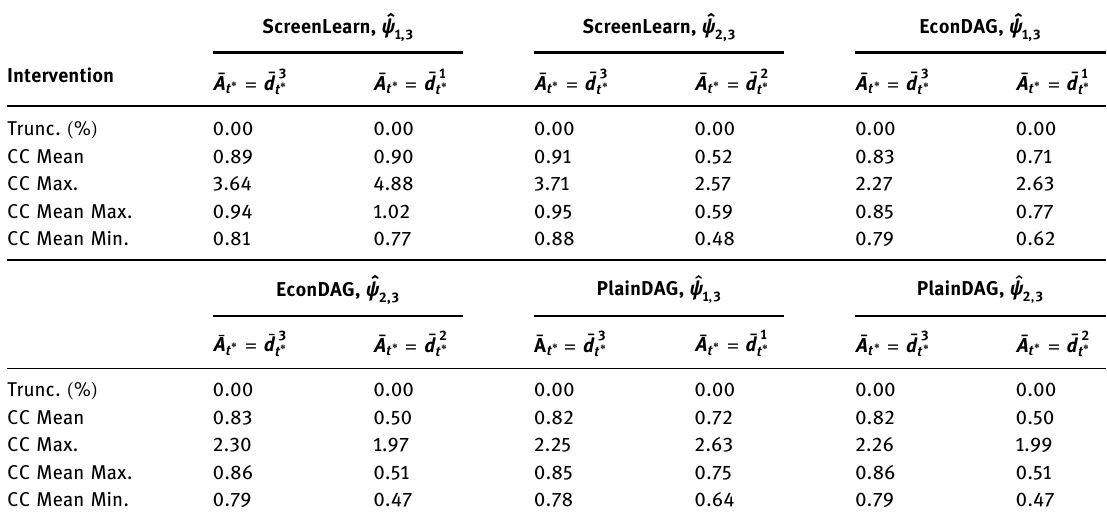
Table 1: Row 1: mean percentage of observations that had to be truncated because the cumulative product of inverse prob - abilities was 0.01 < . Rows 2 and 3: Mean and maximum value of the clever covariate. All results are averaged over the fi ve imputed data sets. Rows 4 and 5 contain the minimum and maximum of the fi ve mean clever covariate values across